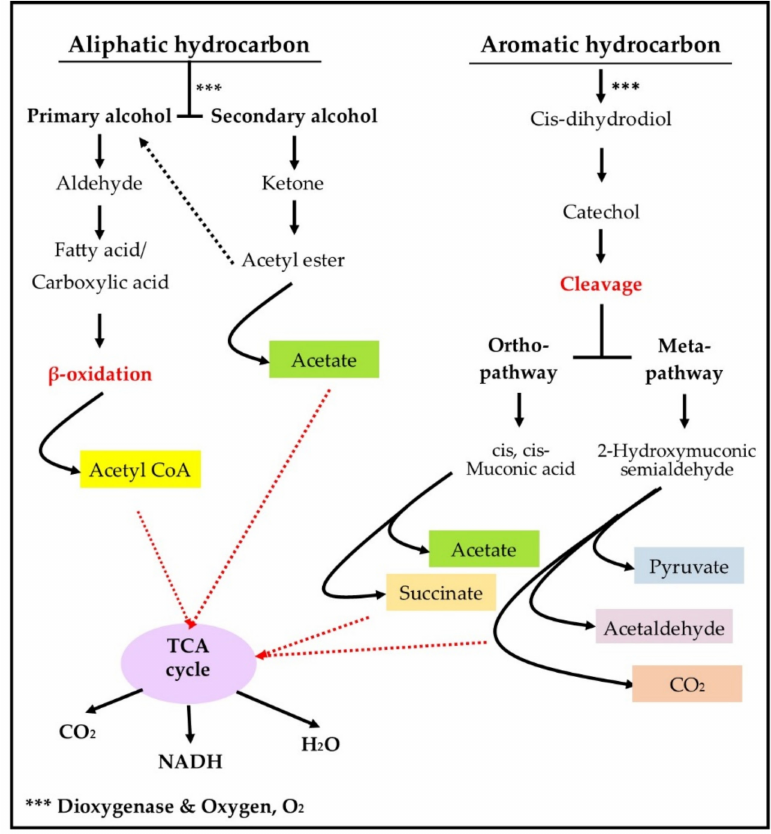
Figure 1. General overview of aerobic biodegradation of hydrocarbons. All end products from aerobic biodegradation will be used in the TCA cycle. Tricarboxylic acid (TCA) cycle is an essen- tial metabolic process that produces important biomass for microbial growth and